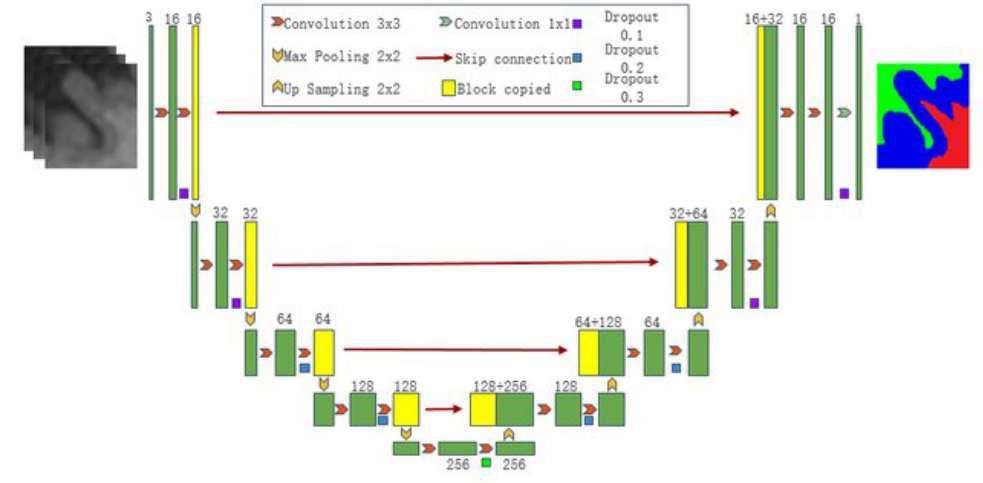
Figure 3. Architecture of U-net [26].